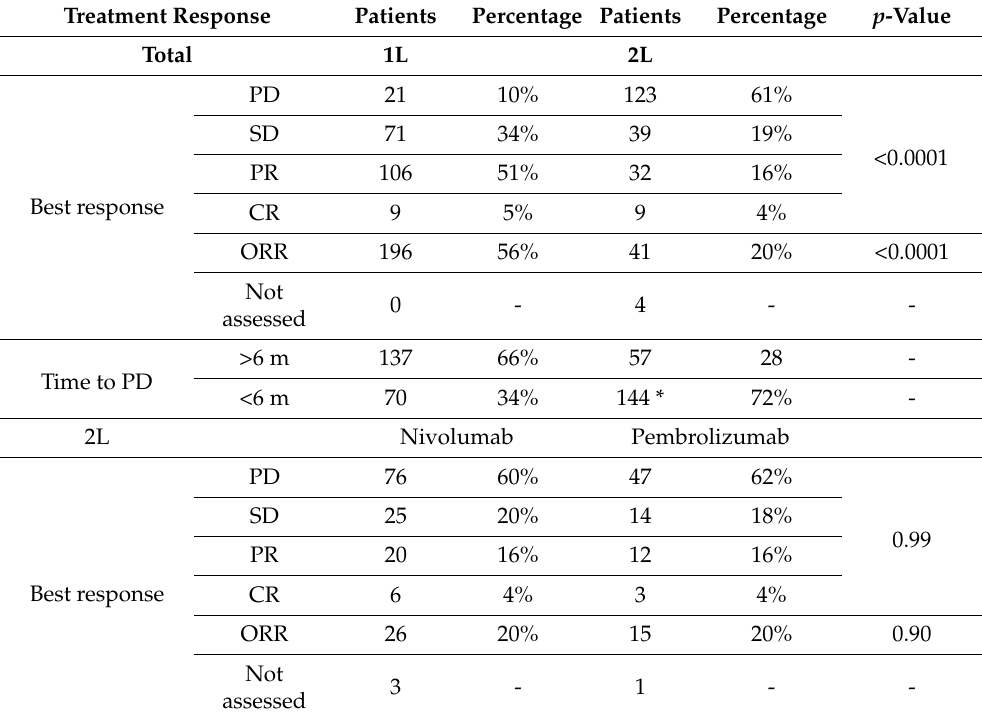
Table 2. Best response on two lines of treatment.